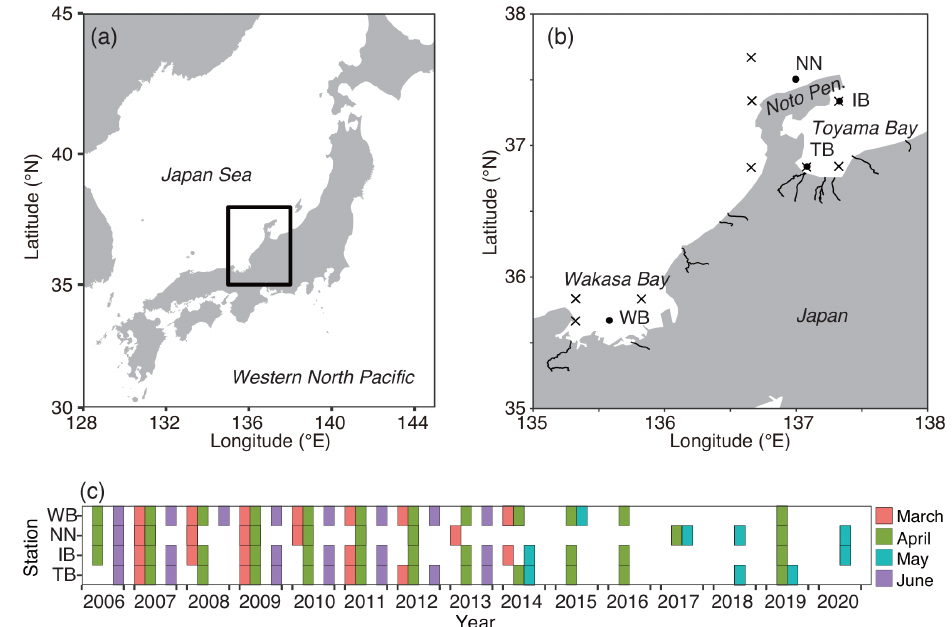
Figure 1. Sampling locations and dates. (a) Location of the study area in the Japan Sea. (b) Distribution of sampling stations of Calanus sinicus (closed circles) and particulate organic matter (POM) for stable isotope analysis along the Japanese coast of the Japan Sea. (c) Months and years of samplings of C. sinicus at the four stations. The lines in (b) denote the downstream reaches of class A rivers. The maps were made with Natural Earth and the Geospatial Information Authority of